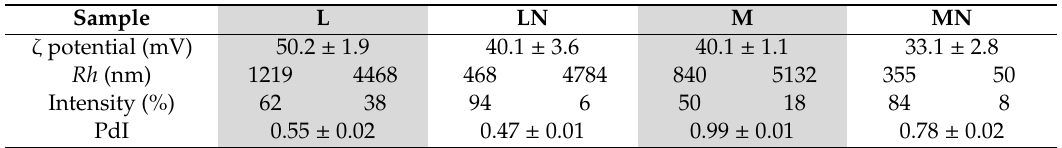
Table 1. Physicochemical characterization of chitosan (CS) samples estimated before (polymers, shaded columns) and after ultrasound irradiation (nanoparticles, non-shaded